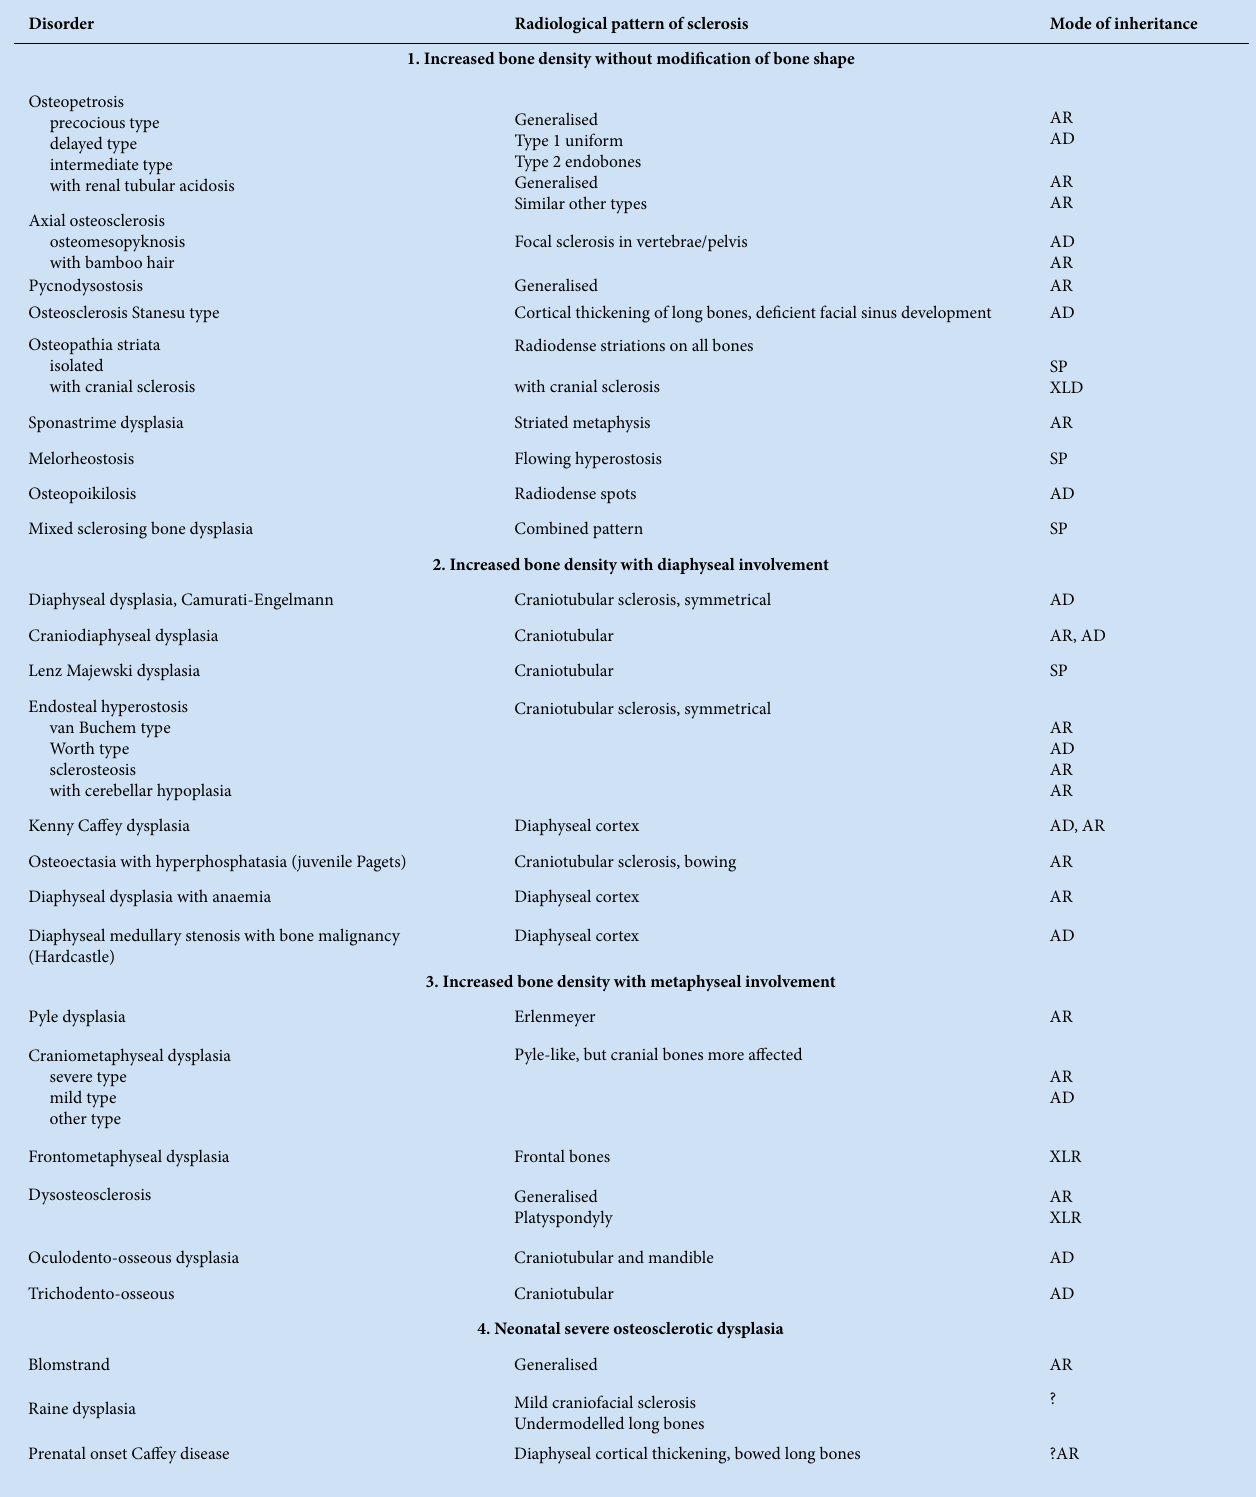
Table I. Classification of dysplasias with increased bone density according to International Nomenclature and Classifications of the Osteochondrodysplasias (modified from Vanhoenacker FM et al . 13